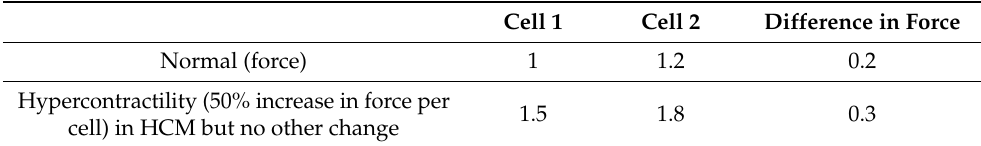
Table 3. Normal differences in force between cells being enhanced by 50% overall increase in